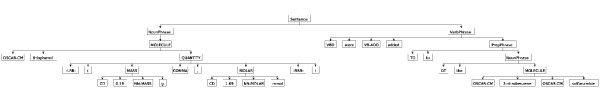
AST Output of ANTLR Parse.